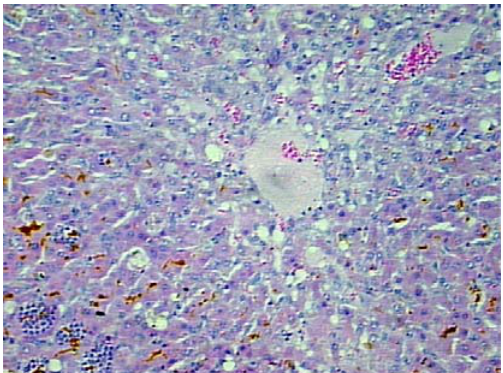
Figure 5. Histological section of the liver: lobe central vein with droplet degeneration (steatolysis); numerous areas of cholestasis (bile); mononuclear glomerular infiltrate; and areas of congestion (hematoxylin and eosin stain,